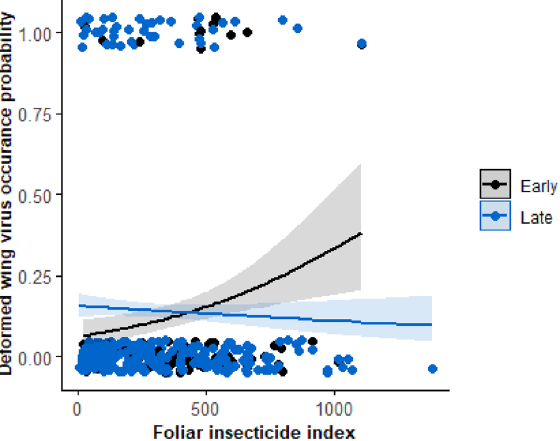
Figure 5. In this figure we show how foliar applied insecticide use surrounding hives is correlated with the occurrence of the deformed wing virus. For honey collected early in the year (June and before—black circles) there is a positive correlation with the foliar insecticide index. This corresponds to the period where agrochemicals are most widely used on crops. However, this pattern disappears for late season honey samples (collected July and after—blue circles) collected when agrochemical use is relatively low. The trend lines showing these correlations include uncertainty in the prediction (confidence intervals) as a grey